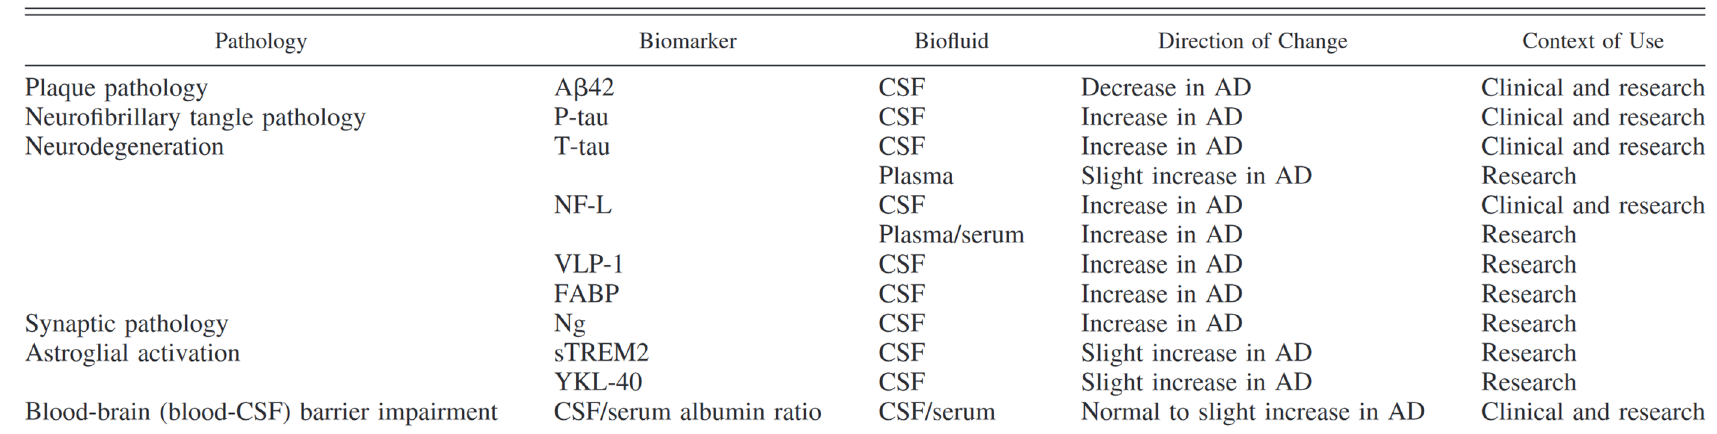
Table 1. Replicated biomarkers detected in biofluids (cerebrospinal fluid and blood plasma/serum) of Alzheimer’s disease patients. Adapted from Zetterberg, 2017 [25].